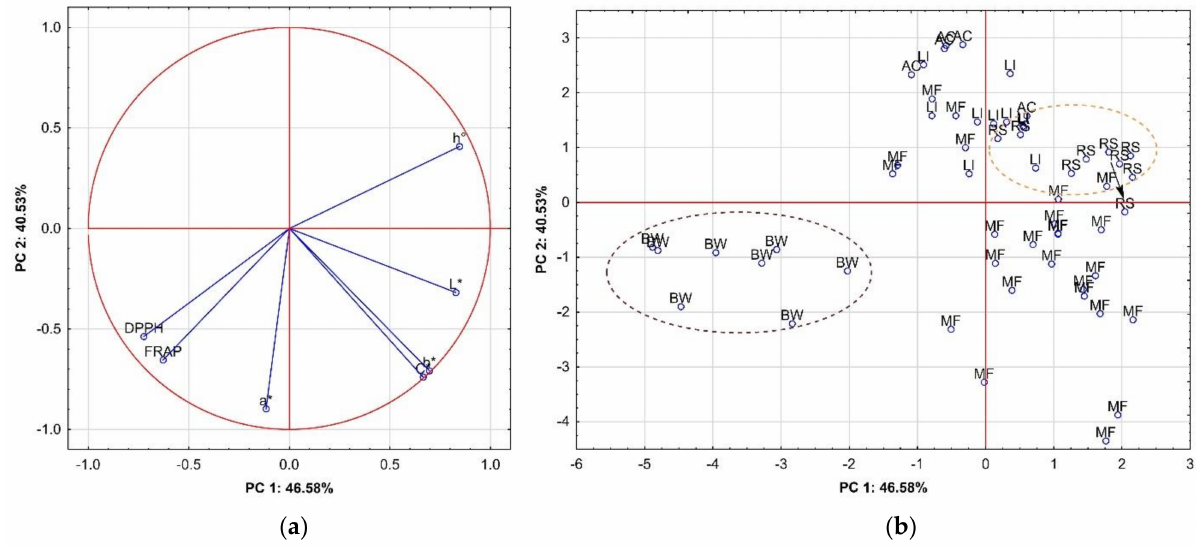
Figure 1. Projection of variables ( a ) and projection of cases ( b ) depending on the botanical origin of the honey in a two-factor plane (PC1 × PC2). ( a ): L*, lightness; a*, redness; b*, yellowness; C*, saturation; h ◦ , hue angle; DPPH, scavenging capacity; FRAP, ferric reducing antioxidant power; ( b ) honey type: RS, rapeseed; BW, buckwheat; LI, linden; AC, black locust; MF,